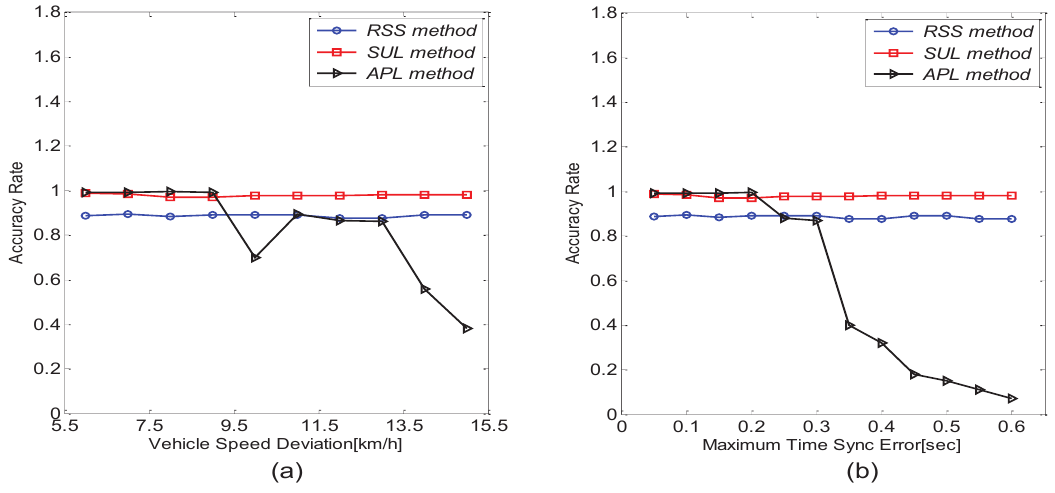
Figure 12. Comparison between the Traffic Lights Schedule (TLS) algorithm and the Autonomous Passive Localization (APL) algorithm. ( a ) The impact of vehicle speed deviation; ( b ) the impact of maximum time sync